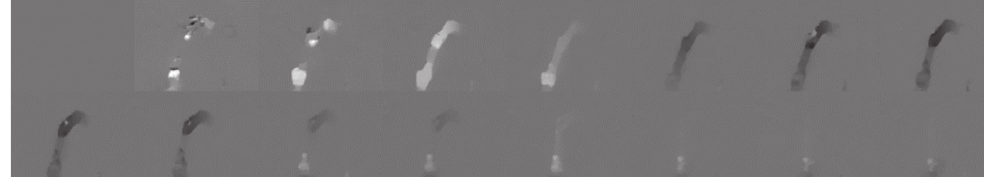
Figure 11: An example of optical flow images for the input of the two-stream